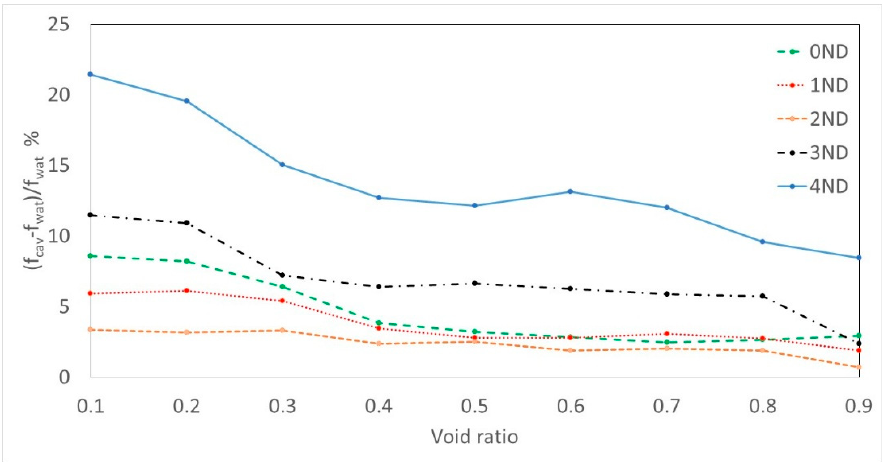
Figure 7. Relative increase of the natural frequencies of the runner under cavitation effects depending on α v considered.